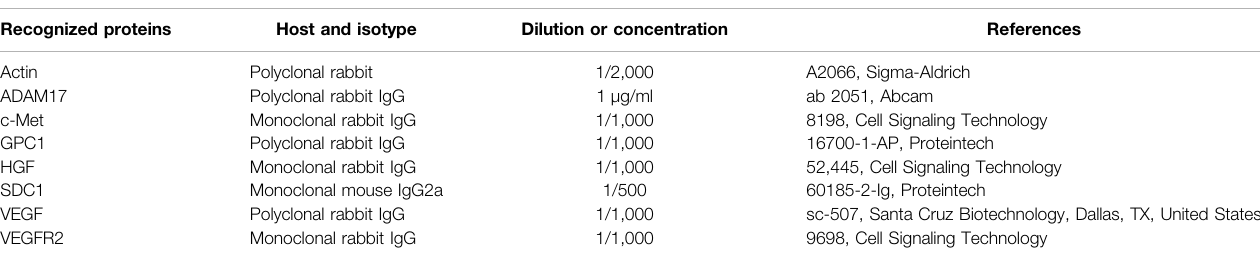
TABLE 3 | List of primary antibodies used in immunoblotting and co-immunoprecipitation experiments. Recognized